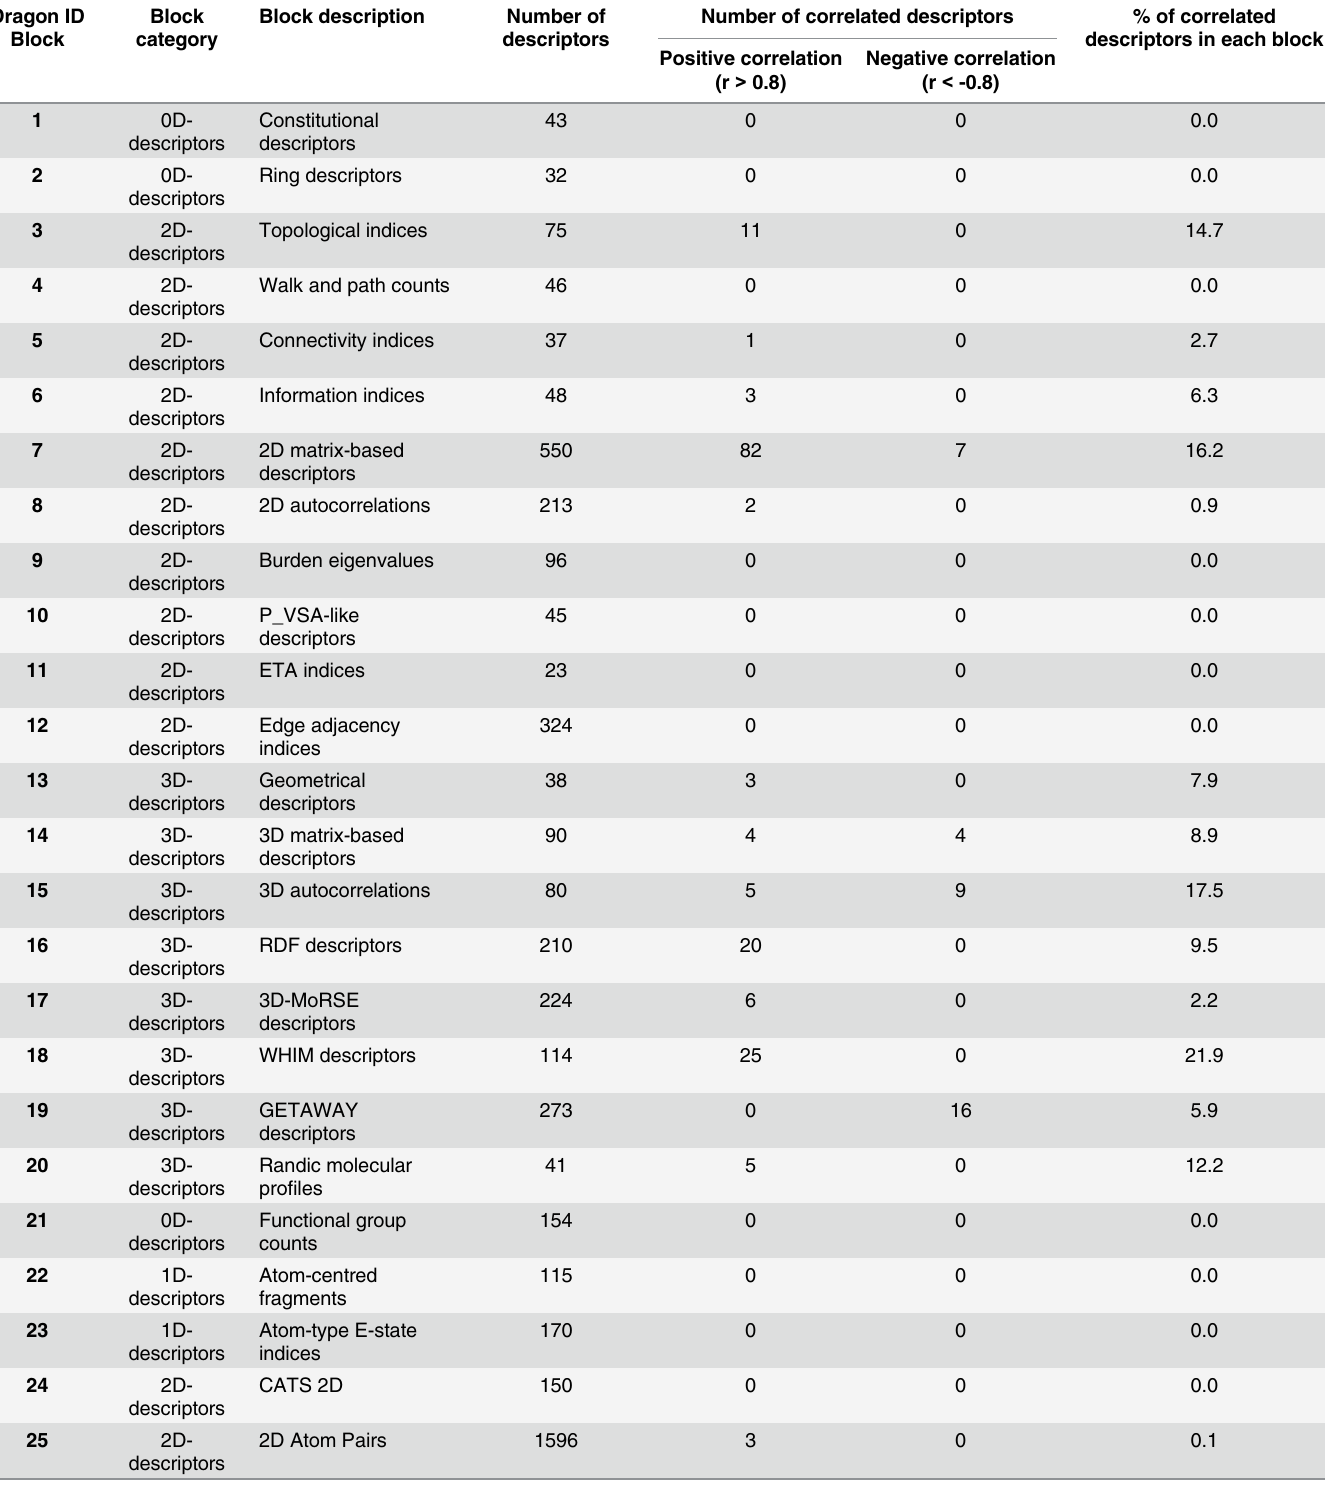
Table 1. Repartition of molecular descriptors correlated with OCT1 activity inhibition for BIMs (|r| >